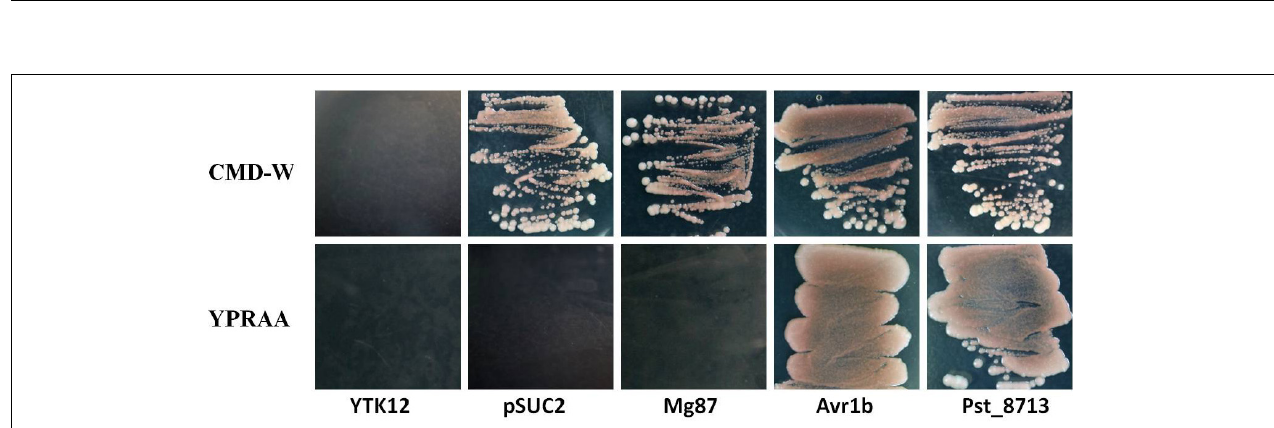
FIGURE 2 | Functional validation of the signal peptide of Pst_8713. The sequence of the putative Pst_8713 signal peptide was fused in-frame to the invertase sequence in the pSUC2 vector and transformed into yeast strain YTK12. The untransformed YTK12 strain, empty pSUC2 vector and the first 25 amino acids of non-secreted Mg87 protein from Magnaporthe oryzae were used as negative controls, and the oomycete effector Avr1b from Phytophthora sojae was used as a positive control. Only yeast strains that are able to secrete invertase can grow on YPRAA media.